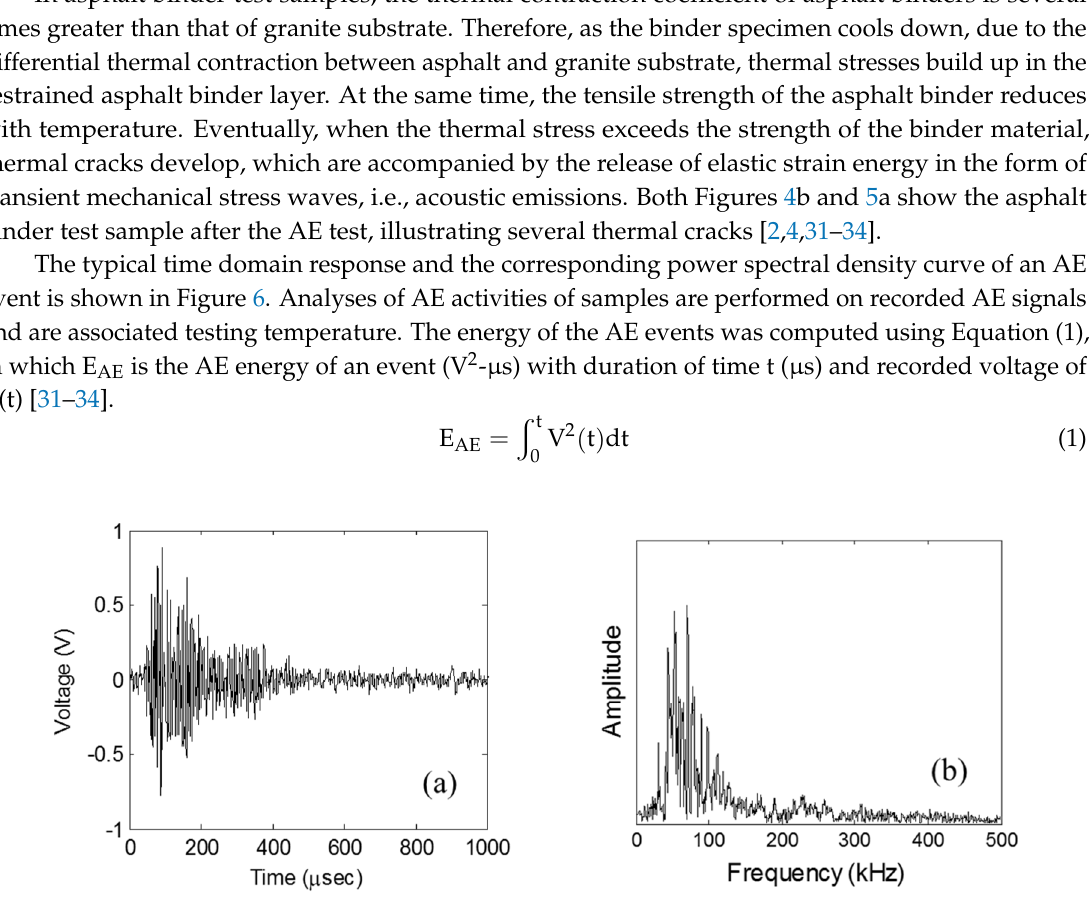
Figure 6. Typical acoustic emission event waveform ( a) and corresponding spectral content ( b ).